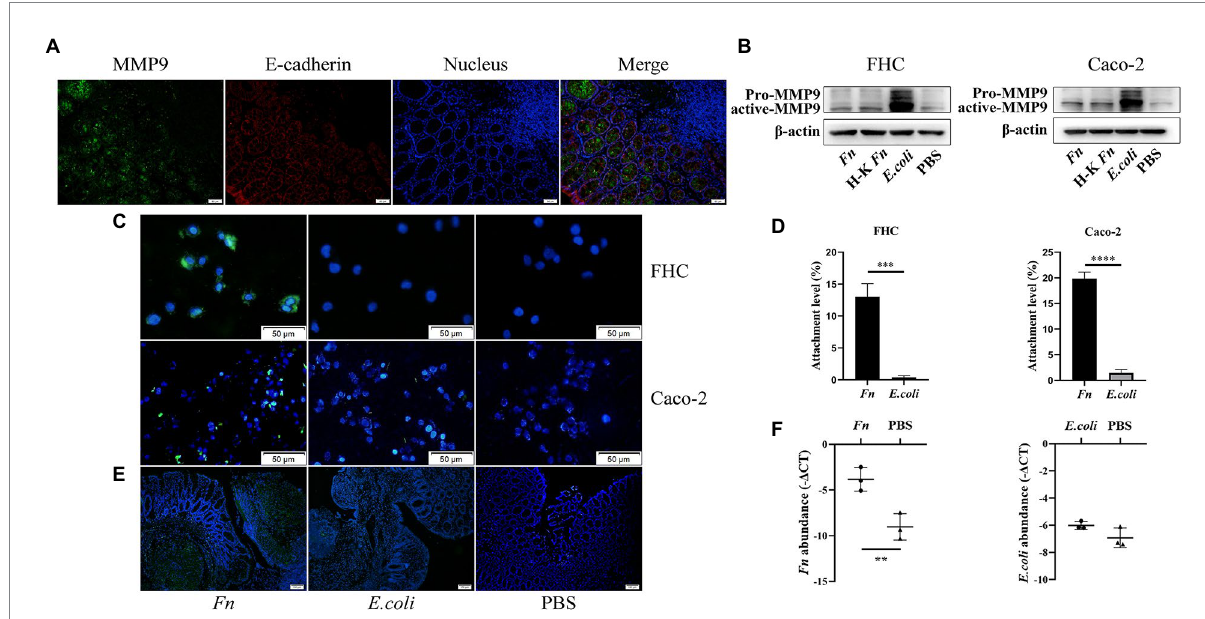
FIGURE 3 The adhesion ability of Fn might be a prerequisite for its pathogenic role in AL. (A) Double immunofluorescence labeling was used to observe MMP9 (green) and E-cadherin (red) location in anastomotic tissues (original magnification, 200×) (bar, 50 μ m). (B) The protein expression level of MMP9 in epithelial cells treated with Fn , H-K Fn , E.coli , and PBS, respectively. (C) After washing with PBS, the amount of attached FITC-labeled Fn and E.coli (original magnification, 200×) (bar, 50 μ m). (D) The ability of Fn and E.coli attached to epithelial cells was detected by cell attachment assay. (E) Rats were processed an enema with FITC-labeled Fn or E.coli on the POD1 and sacrificed 24 h later to measure their colonization ability (original magnification, 100×) (bar, 100 μ m). (F) Relative abundance of Fn and E.coli in anastomotic tissues were calculated by qPCR. ** p < 0.01, *** p < 0.001, **** p <